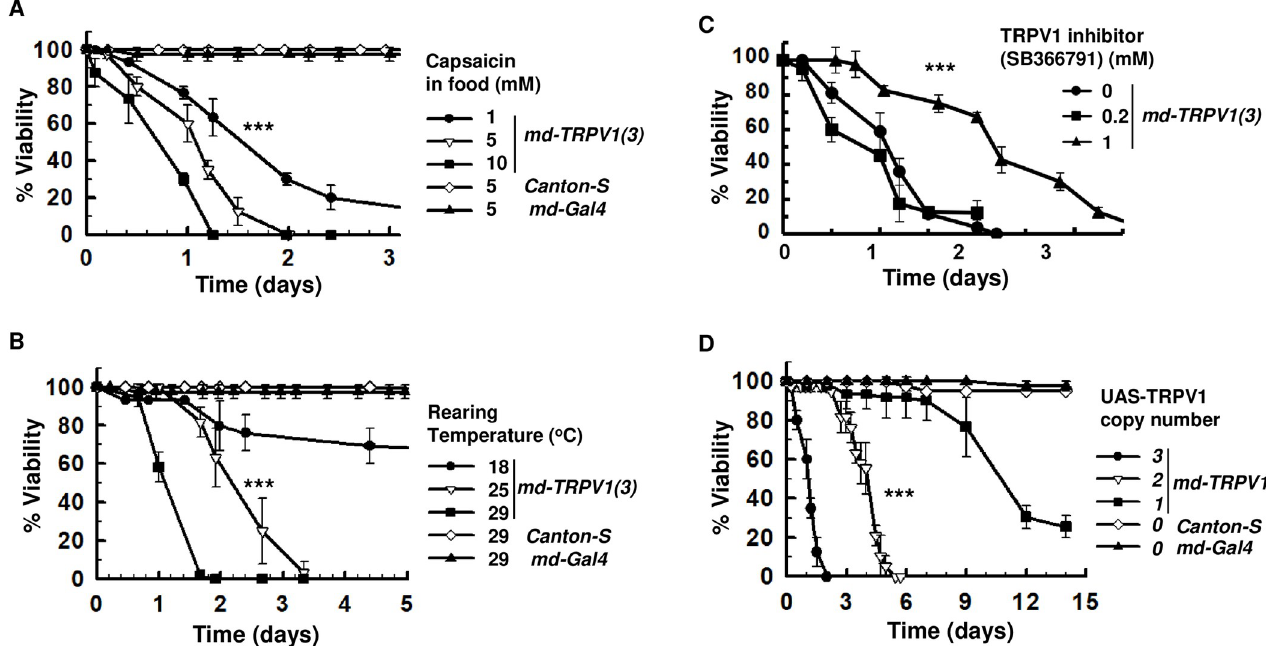
Fig 2. Effect of capsaicin concentration, rearing temperature, a TRPV1 inhibitor, and UAS-TRPV1 copy number on the viability of md-TRPV1(3) flies grown on capsaicin-containing food. (A) Viability of md-TRPV1(3) flies grown at 29˚C on food containing capsaicin at indicated concentrations. Control ( Canton-S or md-Gal4 ) flies were grown at 29˚C on food containing 5 mM capsaicin. Dots and vertical lines denote means and standard deviations, respectively. n = 60 (20 flies per vial) for each capsaicin concentration; one-way ANOVA with the Tukey-Kramer method for multiple comparisons, ��� P < 0.001 for 1 mM vs 10 mM. (B) Viability of md-TRPV1(3) flies grown on 5 mM capsaicin-containing food at the temperatures indicated. Control ( Canton-S or md-Gal4 ) flies were grown at 29˚C on food containing 5 mM capsaicin. Dots and vertical lines denote means and standard deviations, respectively. n = 60 for each temperature; one-way ANOVA with the Tukey-Kramer method for multiple comparisons, ��� P < 0.001 for 29˚C vs 25˚C. (C) Viability of md-TRPV1 (3) on food containing capsaicin (5 mM) and SB366791 at the concentrations indicated. Dots and vertical lines denote means and standard deviations, respectively. n = 60 for each curve; one-way ANOVA with the Tukey-Kramer method for multiple comparisons, ��� P < 0.001 for no SB366791 vs 1 mM SB266791. (D) Viability of md-TRPV1 flies grown on capsaicin (5 mM)-containing food at 29˚C. The number denotes the number of UAS-TRPV1 copies. Dots and vertical lines denote means and standard deviations, respectively. n = 60 for each curve; one-way ANOVA with the Tukey-Kramer method for multiple comparisons, ��� P < 0.001 for two vs three copies of UAS-TRPV1 . Control ( Canton-S or md-Gal4 ) flies were grown at 29˚C on food containing 5 mM capsaicin. md-TRPV1(3) denotes one copy of md-Gal4 and 3 copies of UAS-TRPV1 . All flies were 5- day-old males.